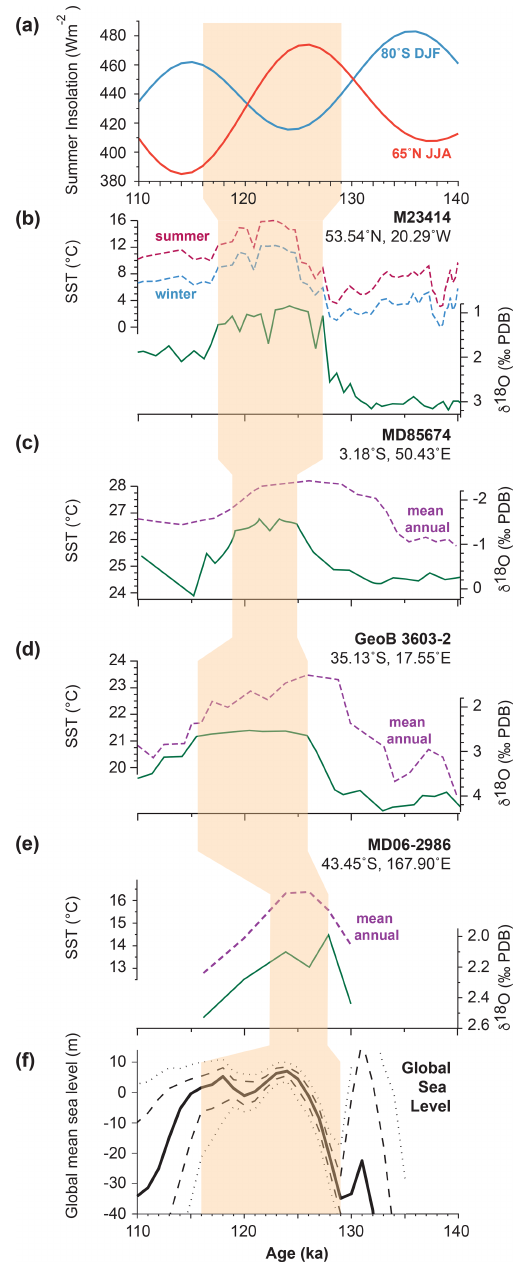
Figure 2. Relationships between δ 18 O plateau and sea surface tem- peratures and environmental changes across the Last Interglacial. (a) Insolation changes calculated from Laskar et al. (2004). Sea sur- face temperatures (dashed purple lines) across the Last Interglacial (light orange shading) compared to the benthic foraminifera δ 18 O data (solid green lines) for selected sites in different ocean basins: (b) M23414 (North Atlantic) (Kandiano et al., 2004), (c) MD85674 (equatorial Indian Ocean) (Bard et al., 1997), (d) GeoB 3603-2 (southern Indian Ocean) (Schneider et al., 1999), and (e) MD06- 2986 (southern Pacific Ocean) (Cortese et al., 2013). (f) The prob- abilistic reconstructed global sea level curve is reported by Kopp et al. (2009); heavy lines mark median projections, dashed lines the 16th and 84th percentiles, and dotted lines the 2.5th and 97.5th per-